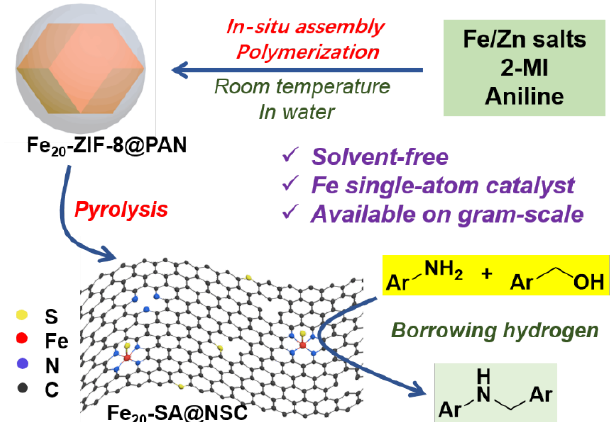
16 of 26 Figure 13. (a) One-pot synthesis of DFF from glucose. ( b ) Synthetic strategy for Fe/C-S catalysts (The illustration proposed the possible structure in the catalyst). Reprinted with permission from Ref. [87]. Copyright 2017, Royal Society of Chemistry.5.2. N-Alkylation Reactions. 5.2. N-Alkylation Reactions Our group prepared a stable and recoverable N, S-codoped Fe 20 -SA@NSC catalyst